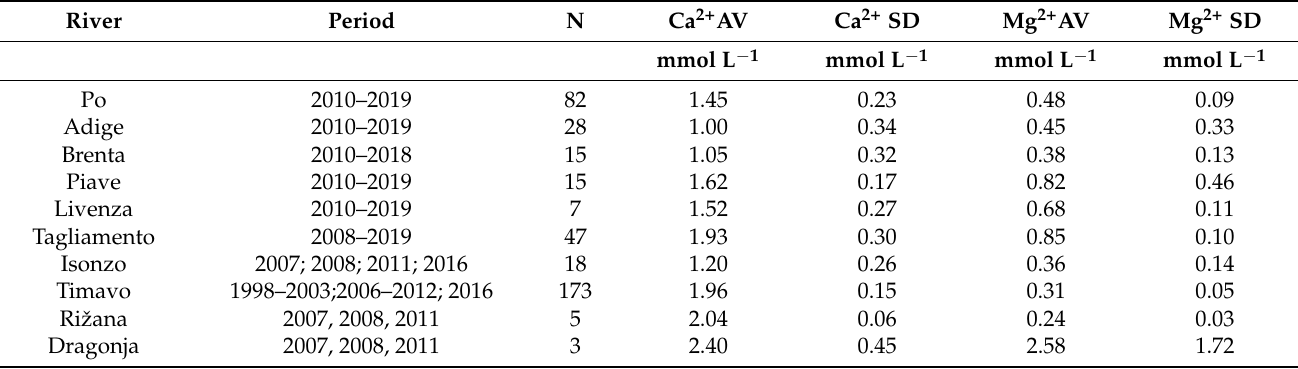
Table A4. Calcium and magnesium concentrations (mmol L − 1 ) in the riverine waters. Average (AV), standard deviation (SD) and number of measurements (N) are